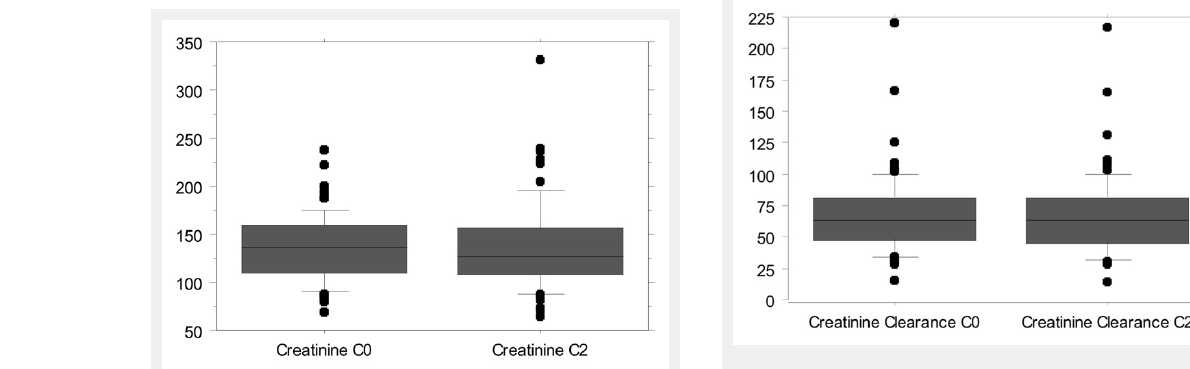
Figure 2 Creatinine clearance: 68.1 ± 32.74 ml/min during the C0 monitoring period vs. 67.9 ± 33.14 ml/min during the C2 monitoring period (p =